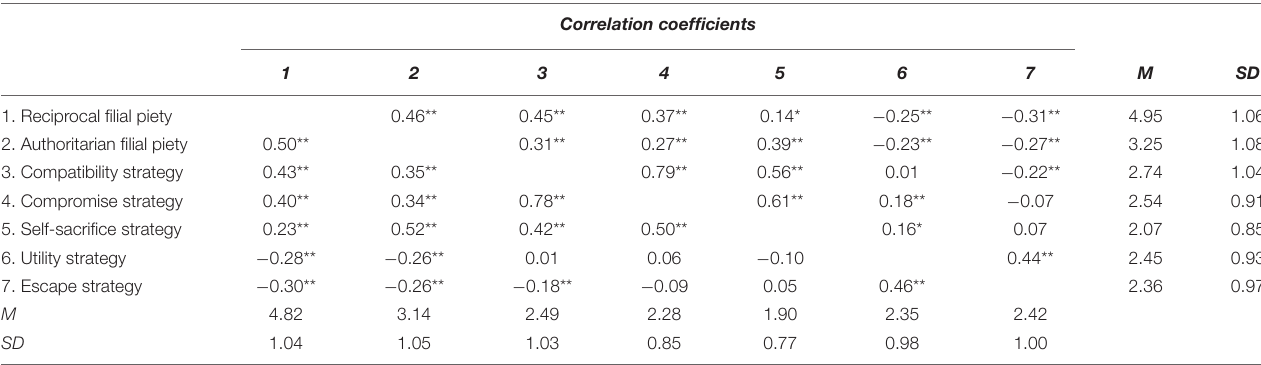
TABLE 1 | Correlations, means, and standard deviations of the main variables in Study